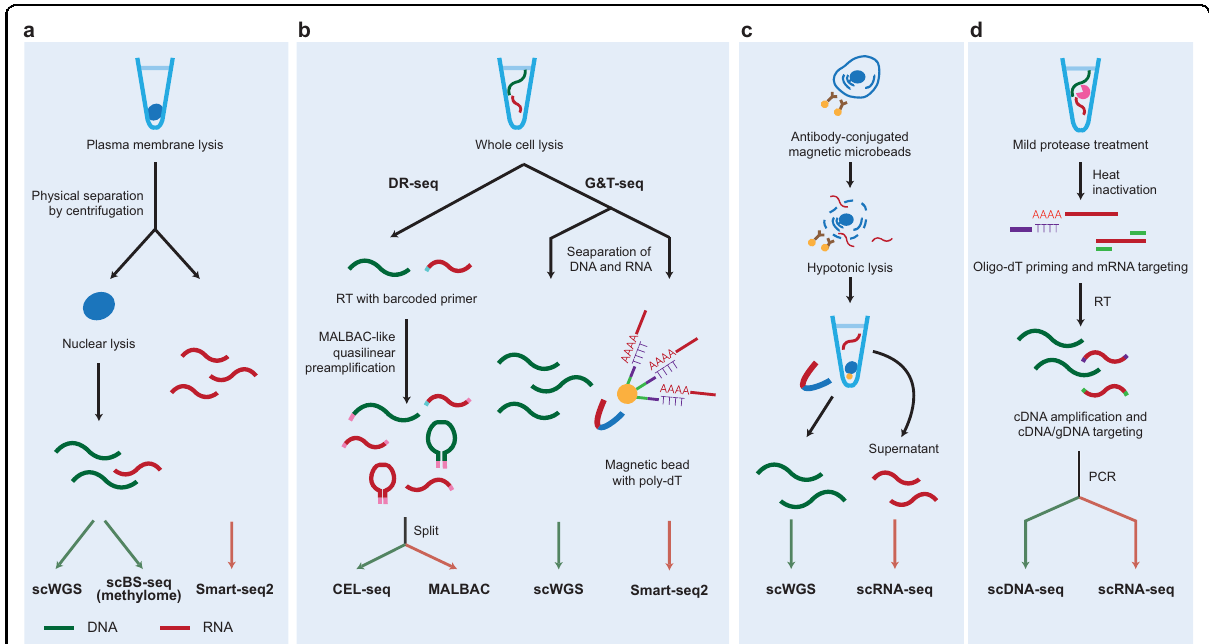
Fig. 2 Single-cell multiomics sequencing protocols for the integrative analyses of the genome and transcriptome. Protocols for the isolation of single cells or nuclei and the barcoding of gDNA and mRNAs are shown for fi ve types of multiomics analyses of the genome and transcriptome: scTrio-seq ( a ), DR-seq and G&T-seq ( b ), SIDR ( c ), and TARGET-seq ( d ). Blue solid circles, nucleus; blue dotted line, permeabilized membrane; red and green lines, mRNA and gDNA, respectively; yellow solid circles, beads; Y shapes, antibodies; magenta and green fragments, barcodes or primers; and U shapes, magnets. See text for the de fi nitions of the